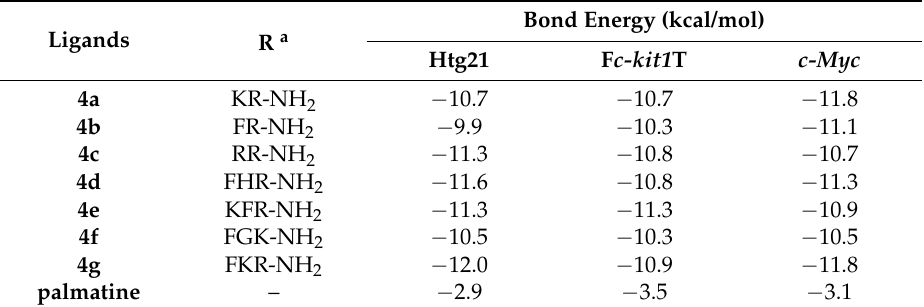
Table 6. Energetic values of the bond between palmatine derivatives with c-kit1, c-Myc and Htg21 G-quadruplex structures by MST